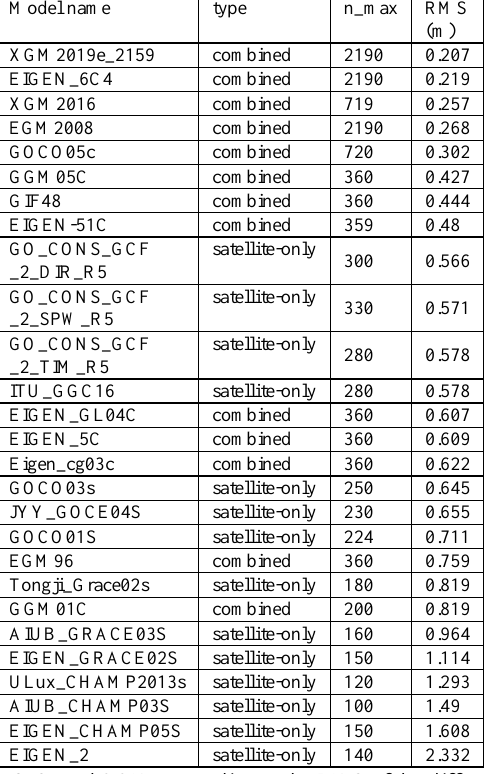
Table 2 . Sorted GGMs according to the RMS of the differences between the geoidal heights computed via GGMs and the available geoidal heights of 841 GPS/Levelling stations in Iran.